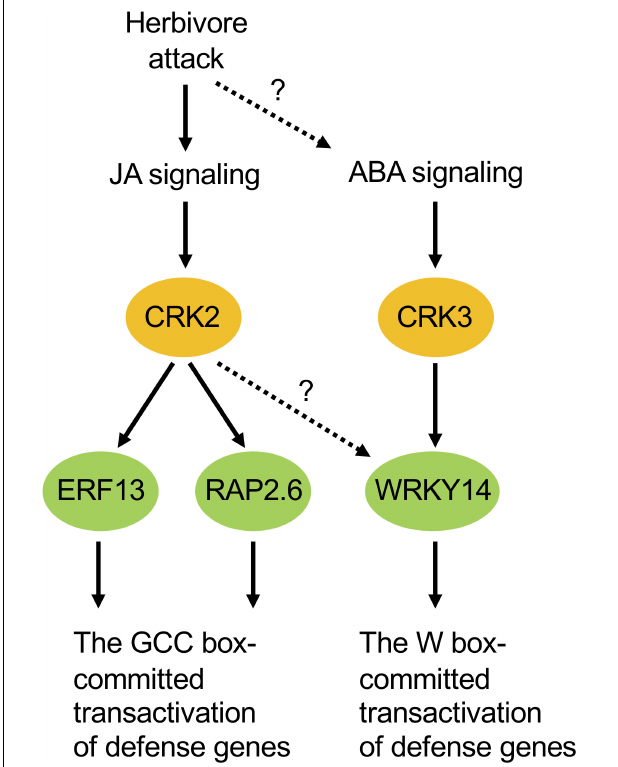
FIGURE 7 | Possible model of cellular signaling mediated by CRKs under herbivore attack. ABA, abscisic acid; JA,